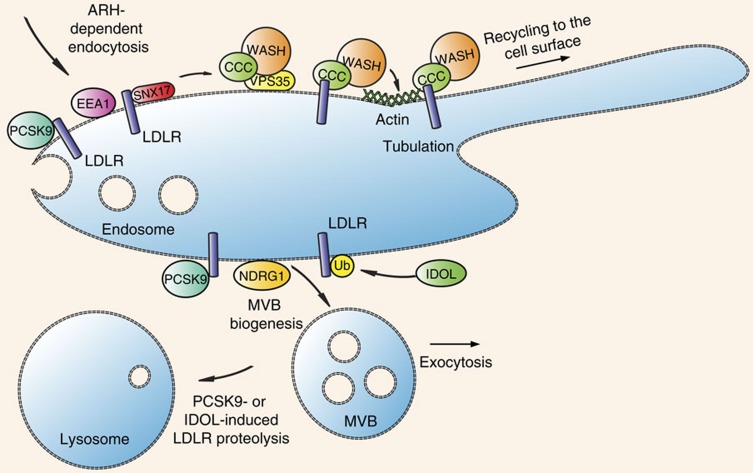
Hypothetical model of CCC- and WASH-mediated endosomal LDLR sorting.After internalization mediated by ARH, LDLR is sorted in endosomes58. LDLR is directed to the lysosome for proteolysis—which is induced by either PCSK9 (refs 59, 60) or IDOL61—or retrieved and recycled back to the cell surface. SNX17 enhances LDL endocytosis likely by promoting LDLR retrieval44, which might precede CCC and retromer/WASH-mediated endosomal trafficking. Through the interaction of the retromer component VPS35 with FAM21 the WASH complex and the CCC complex are recruited to the endosomes248. Subsequently, CCC and WASH form a protein complex with LDLR; WASH facilitates the formation of branched actin patches to define restricted domains of the endosomes62 from where LDLR is sorted back to the cell surface. NDRG1 is required for the formation of MVB: loss of NDRG1 impairs LDL uptake and LDLR recycling, and causes the accumulation of IDOL-mediated ubiquitinated LDLR in MVB48. Further research is needed to assess whether CCC and WASH are functionally related to SNX17, NDRG1 and to the lysosomal degradation pathways of LDLR. ARH, autosomal recessive hypercholesterolaemia protein; MVB, multivesicular body; PCSK9, proprotein convertase subtilisin/kexin type 9; Ub, ubiquitin; WASH, WASH1, FAM21, strumpellin, KIAA1033, CCDC53.